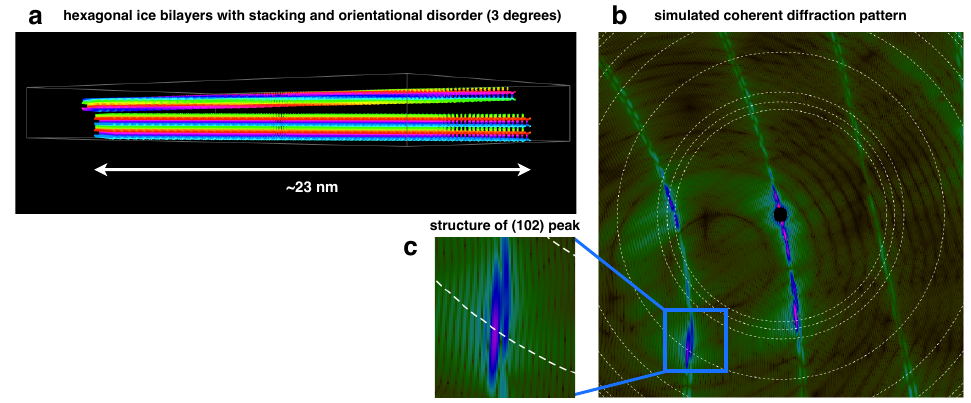
Figure A16. ( a ) Nanoscopic model of oxygen atoms in hexagonal ice bilayers with stacking and orientational disorder (3 ◦ ), colored to show height from base. ( b ) Simulated coherent diffraction pattern of hexagonal ice layers with stacking and orientational disorder. The diffraction pattern exhibits clear crystal truncation rods. The dashed white lines show the expected locations of the Bragg peaks for hexagonal ice I h [51]. ( c ) A zoom-in on the (102) peak in reciprocal space showing several